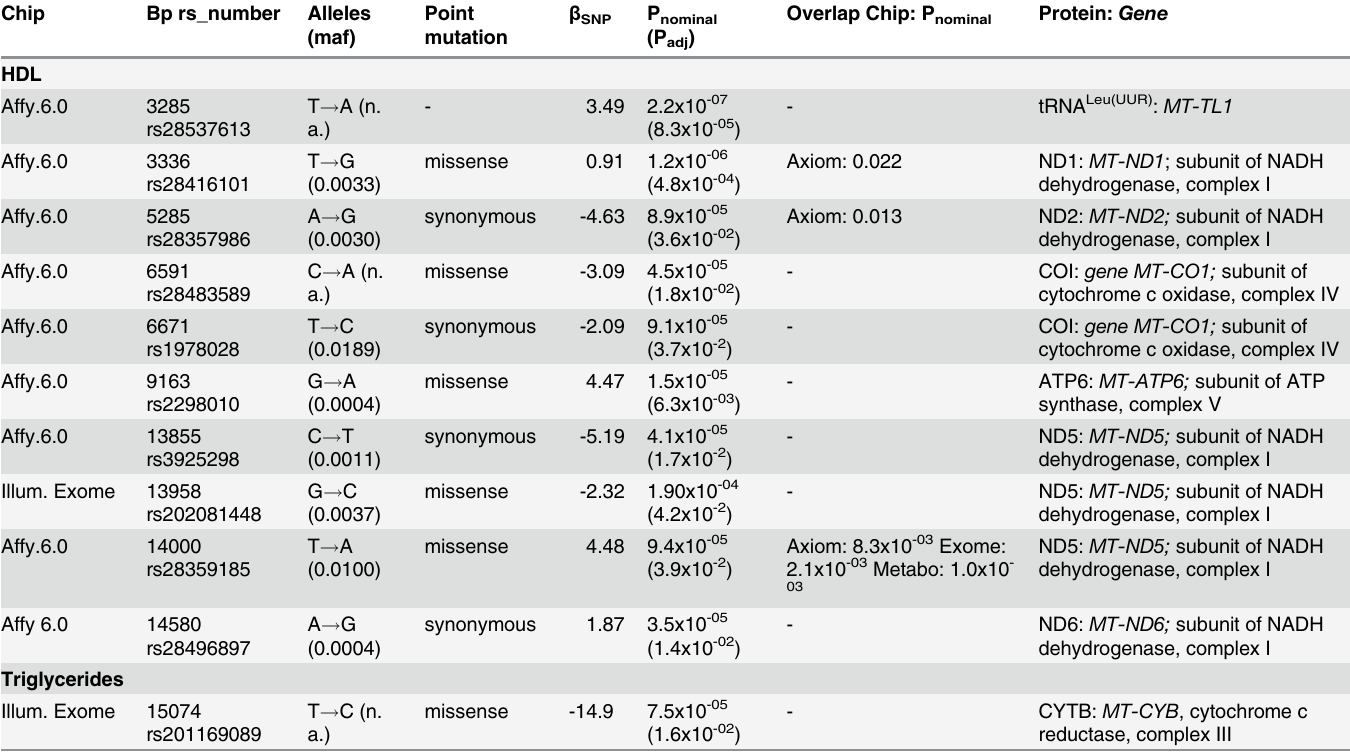
Table 3. Summary of significant